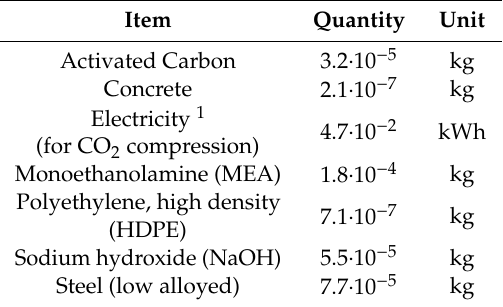
Table A1. Foreground inventory of life-cycle inputs for carbon capture and storage (CCS) technology, complementing natural gas combined cycle (NGCC) power plants. All values are per kWh of electricity